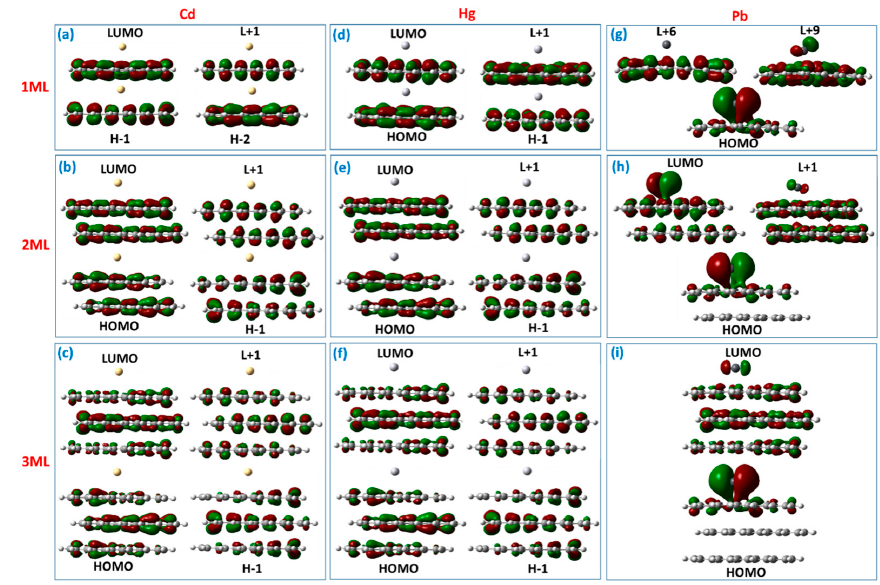
Figure 5. Images demonstrating the spatial distribution of wave-functions corresponding to occupied and unoccupied orbitals, which are involved in electronic transitions in monolayer, bilayer, and trilayer GQDs after interaction with elemental heavy metals: ( a – c ) Cd, ( d – f ) Hg, and ( g – i ) Pb, respectively. The red and green colours indicate positive and negative phases in the wave function, respectively. The orbitals are drawn at an isosurface value of 0.02.